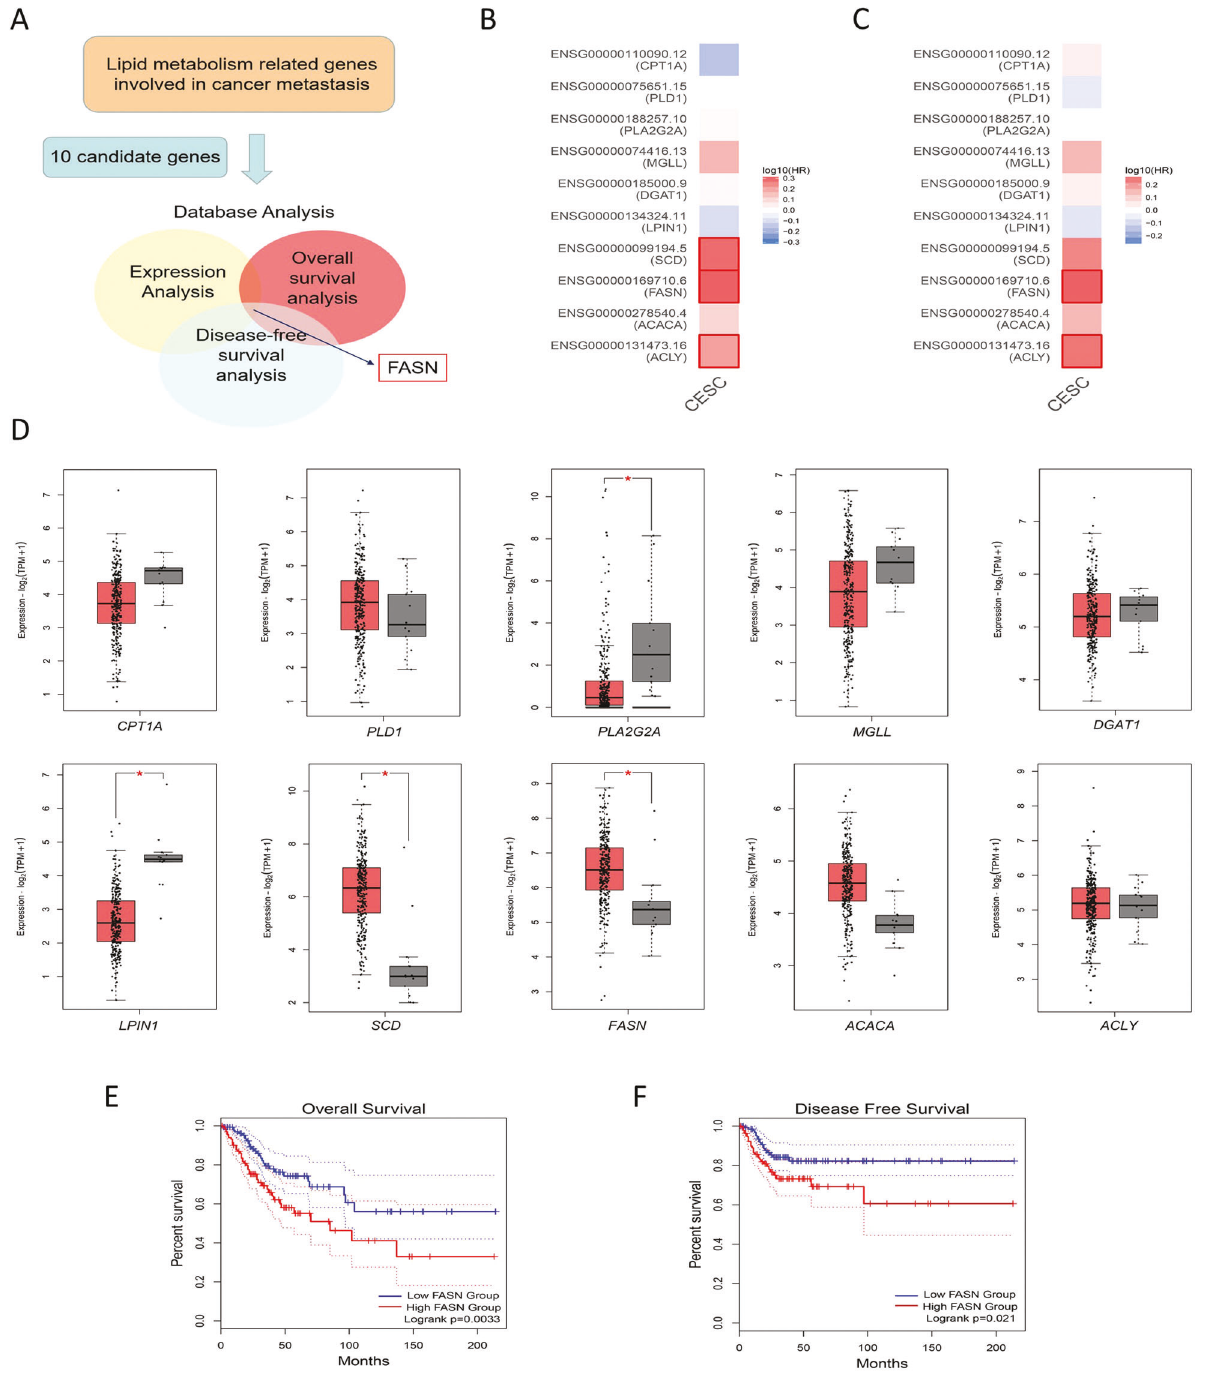
Fig. 1 Identi fi cation of FASN in CC based on TCGA dataset analysis. A Detailed screening work fl ow using TCGA database to identify FASN. B The overall survival map of 10 lipid metabolism-related genes involved in cancer metastasis. The red border indicates the genes with signi fi cant P values. C The disease-free survival map of the same genes in B . The red border indicates the genes with signi fi cant P values. D Expression analysis in CC and normal cervical samples in TCGA and GTEx datasets. The red box represents the CC group ( n = 306), while the gray box shows the normal tissue samples ( n = 13). E Overall survival analysis based on FASN expression level in TCGA database. F Disease- free survival analysis based on FASN expression level in TCGA database. * P < 0.05; ** P < 0.01; *** P < 0.001. treatment but not GSK2194069 and orlistat (Fig. 4C, D). C75 and targeted siRNA while FASN overexpression led to increased total Cerulenin could target the ketoacyl synthase (KS) domain while and free cholesterol (Fig. 4A, B). Furthermore, 4 FASN inhibitors, the GSK targets ketoacyl reductase (KR) domain and Orlistat which target different domains of FASN, were applied to further targets the thiosterase (TE) domain, which indicated that C75 and prove the effect of FASN on cholesterol metabolism, the results of Cerulenin could inhibit acetoacetyl-CoA while GSK and Orlistat which demonstrated a similar pattern to that of C75 and Cerulenin